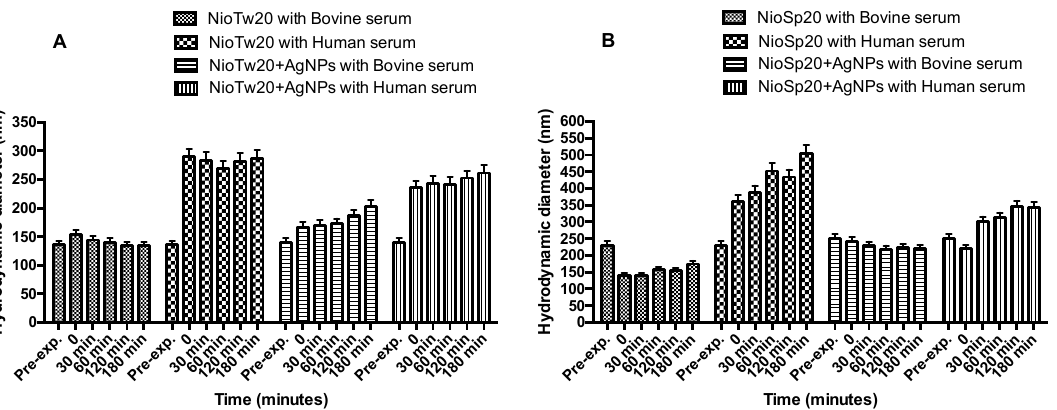
Figure 4. Stability studies of empty niosomes and Nio-AgNPs at room temperature and 4 °C.